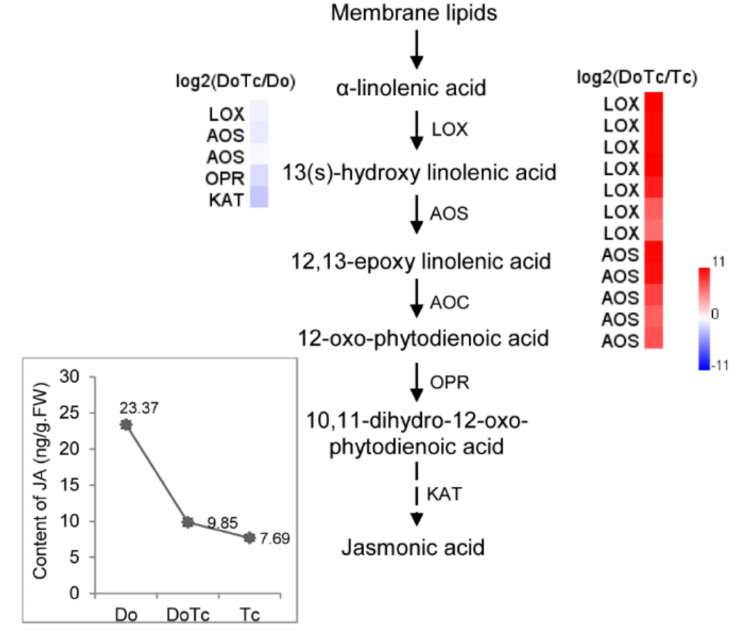
Figure 4. The genes involved in the biosynthesis of the oxylipin JA identified in the symbiotic germinated seeds of D. officinale in association with a Tulasnella sp. isolate. LOX: Linoleate 13S-lipoxygenase; AOS: Allene oxide synthase; AOC: Allene oxide cyclase; OPR: 12-oxophytodienoate reductase; KAT: 3-ketoacyl-CoA thiolase; JMT: Jasmonate O-methyltransferase. Red and blue indicate up- and down-regulated transcripts, respectively, from the DoTc vs. Do and DoTc vs. Tc comparisons. Each data point represents the mean of six biological replicates. Bars represent the standard error of the mean, SE ( n =